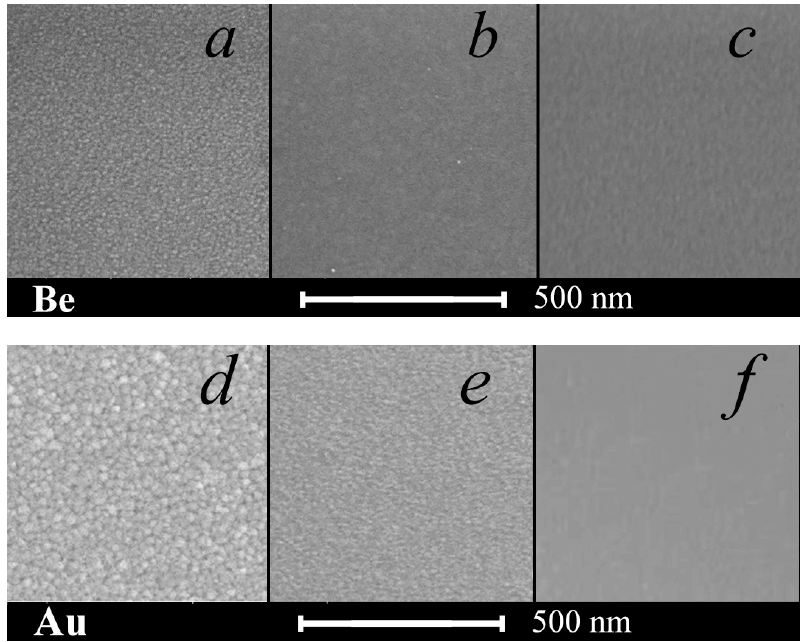
Figure 2. SEM image of the beryllium and gold film surfaces with a single deposition onto the initial silicon surface ( a , d ), with a single repeated deposition ( b , e ), and with tenfold deposition onto the activated silicon surface ( c , f ).